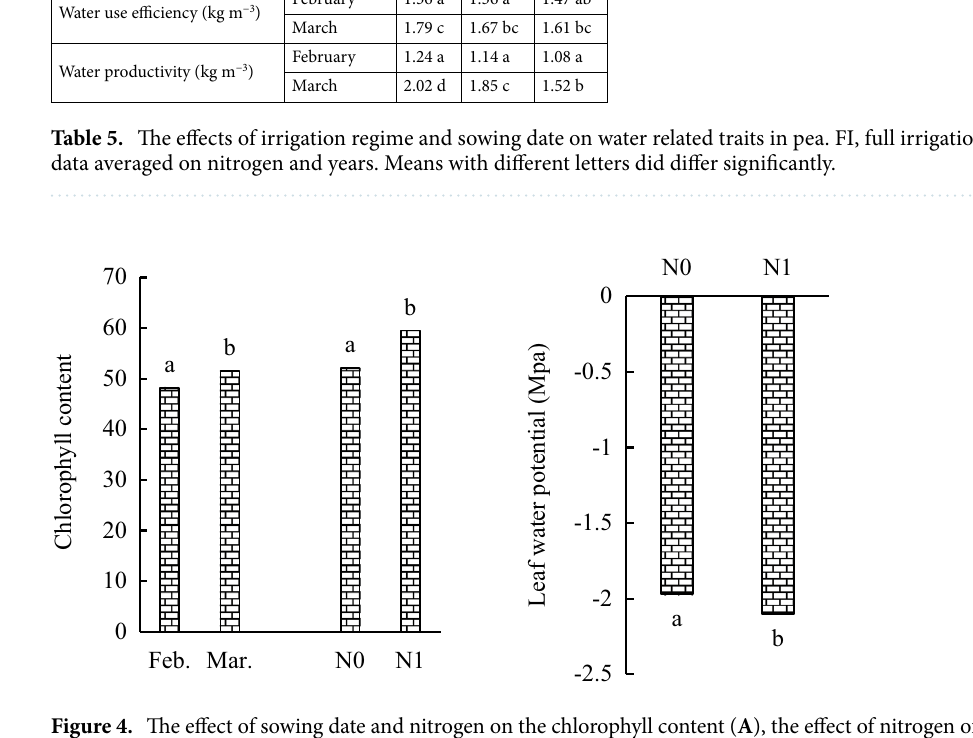
Figure 4. The effect of sowing date and nitrogen on the chlorophyll content ( A ), the effect of nitrogen of leaf water potential ( B ) in pea. N: nitrogen, Feb: February, Mar: March. Means with different letters did differ